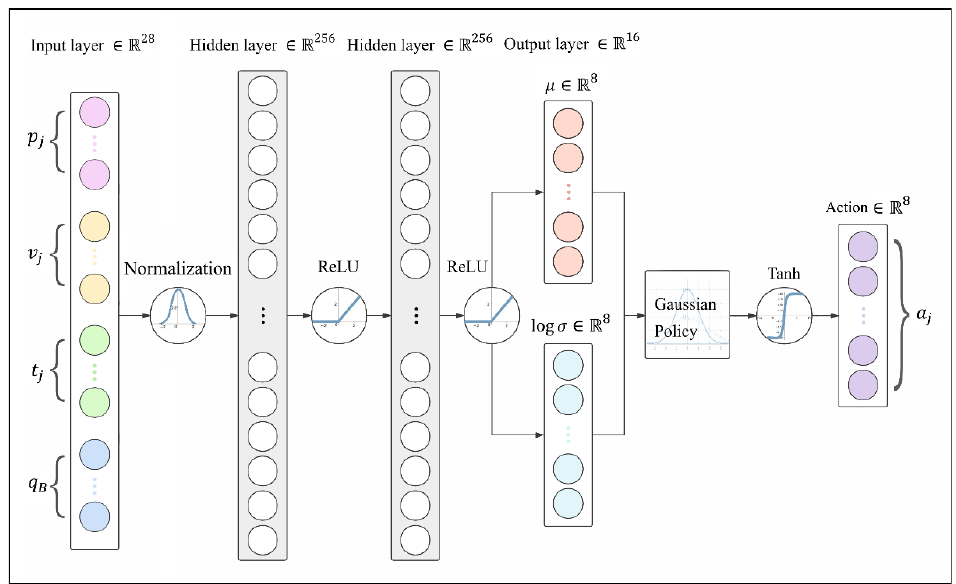
Figure 2. ANN-based Tanh Gaussian policy.